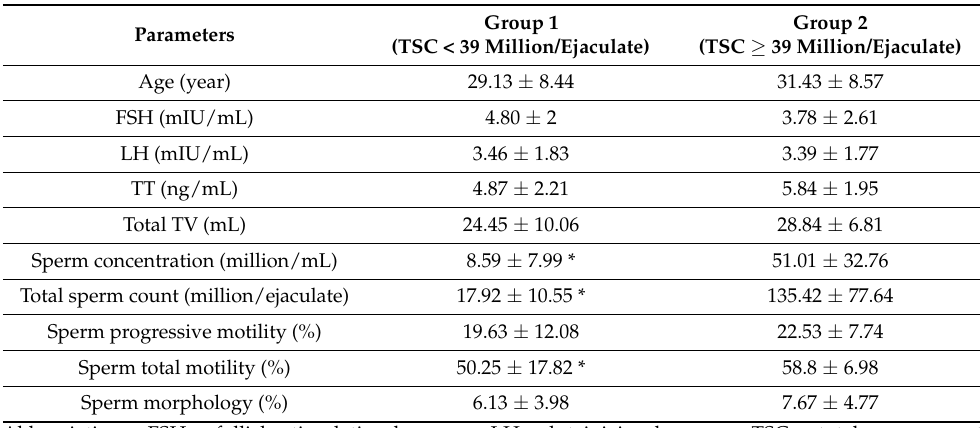
Table 3. Range and baseline values of Groups 1 and 2.